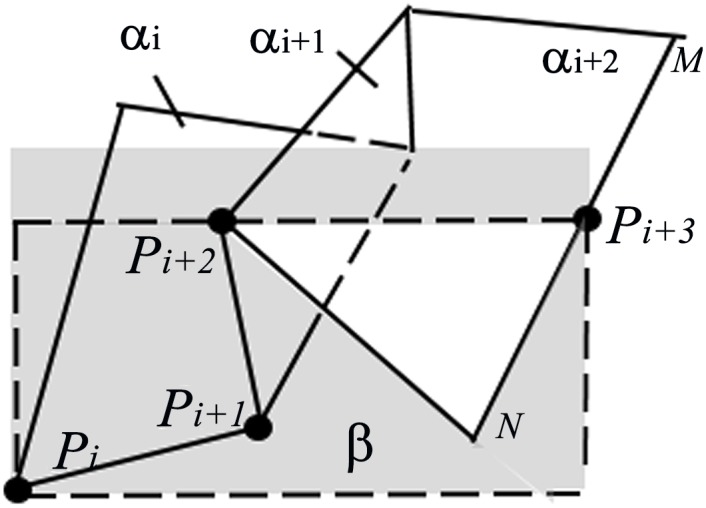
Three of the plane widgets αiαi+1αi+2 being transected by plane β.β is perpendicular to the plane widget α1 and α2.